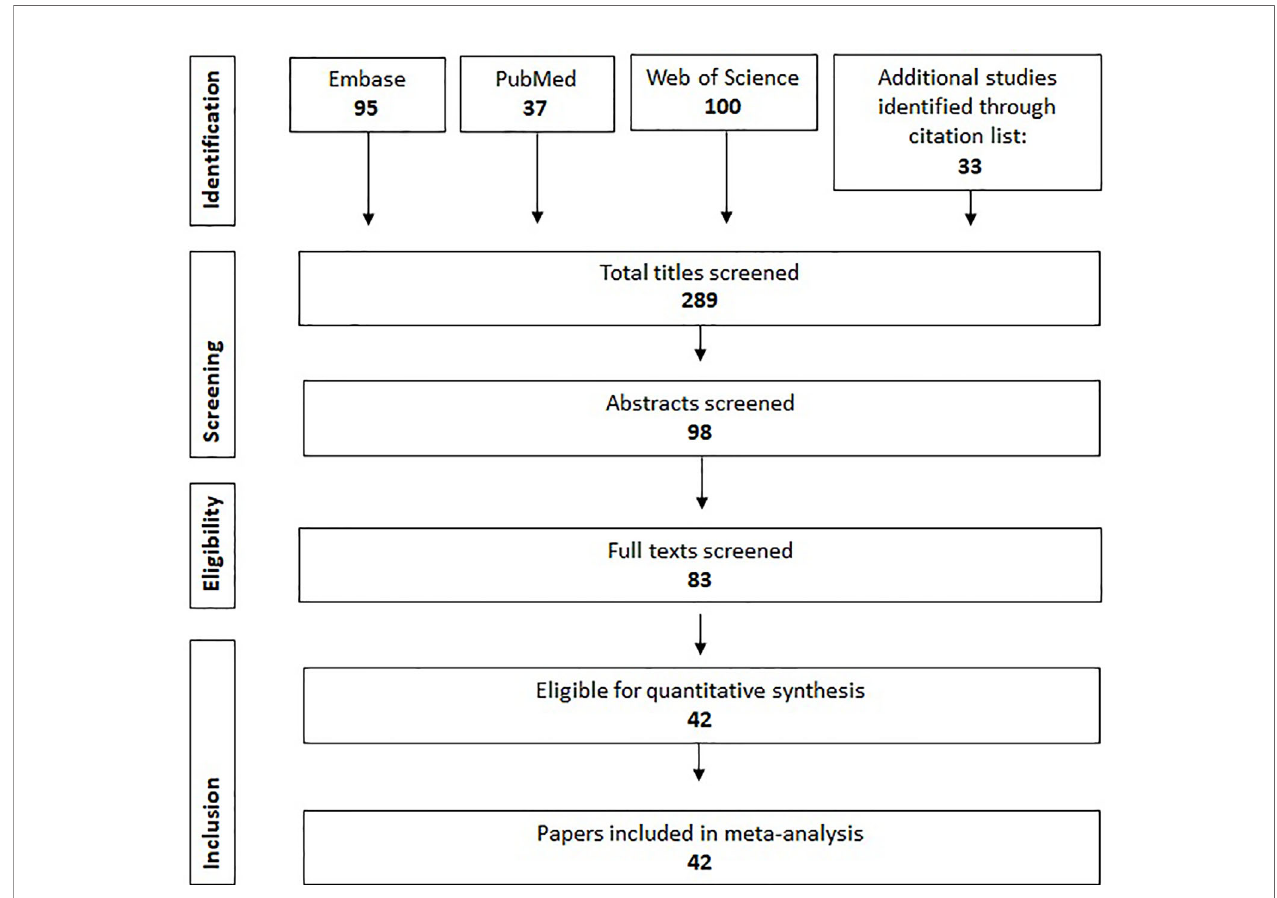
FIGURE 1 | Flowchart describing the methodology of article